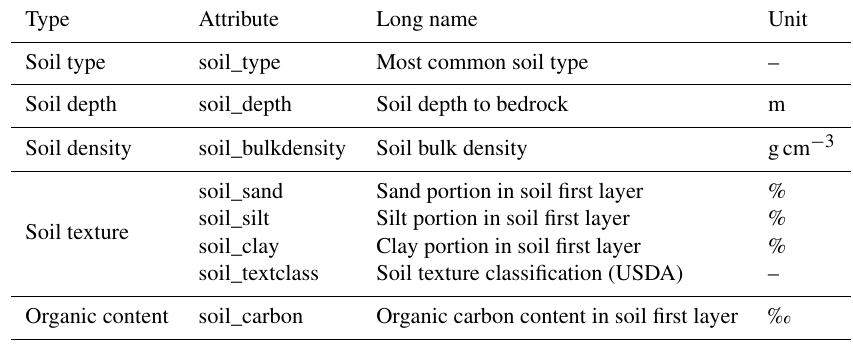
Table 6. Soil attributes of the CABra catchments.